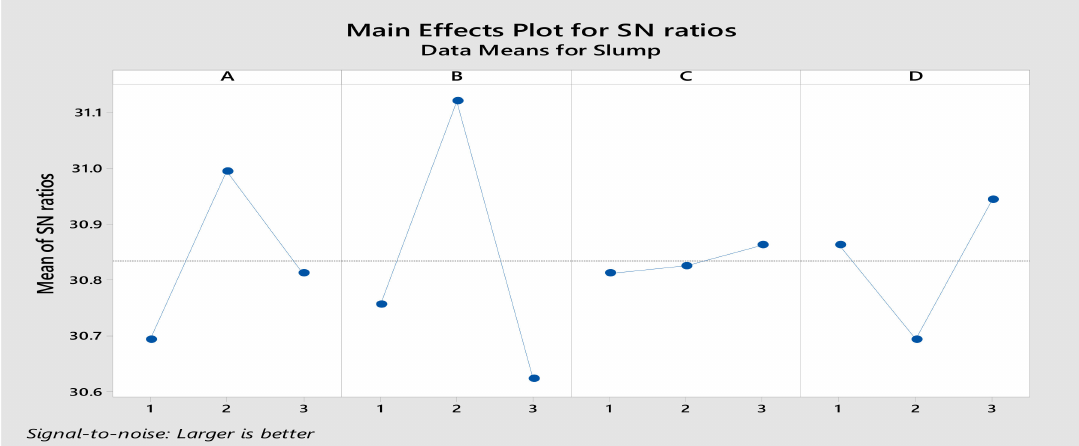
Figure 7. Main effects plot of SN ratios for slump using the Taguchi